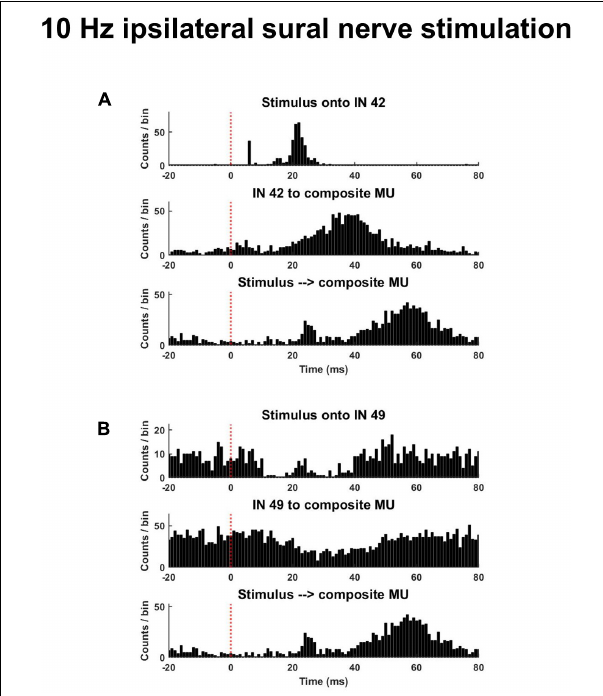
FIGURE 3 | Exemplar peristimulus time histograms during a trial of low frequency (10 Hz) ipsilateral sural nerve stimulation. (A) Shown is an interneuron that displayed an increased probability of discharge in response to the stimulus and whose discharge was associated with an increased probability of motor unit discharge [ (A) , middle panel]. (B) Displayed is an interneuron that displayed a reduced probably of discharge and whose discharge was associated with a decreased probably of motor unit discharge [ (B) , middle panel]. The same composite motor unit spike train in response to the stimulus is shown on the bottom panel of panels (A,B)